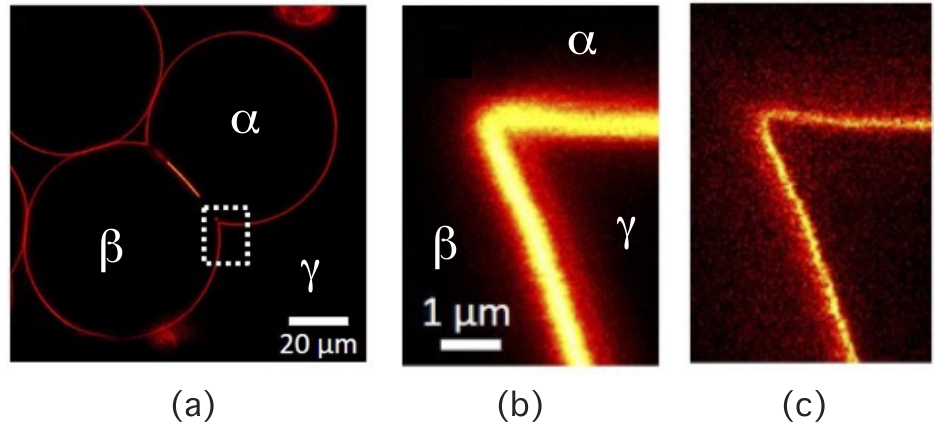
Figure 14. Apparent membrane kinks are low-resolution images of highly curved membrane seg- ments: ( a ) GUV with an interior compartment that contains a PEG-rich α droplet and a dextran-rich β droplet. The region enframed by the white-dashed rectangle contains one membrane kink which is enlarged in panels b and c; ( b ) In the confocal microscope, the highly curved membrane segment cannot be resolved; and ( c ) In the STED image, the smoothly curved segment leads to a contour curvature radius of about 220 nm